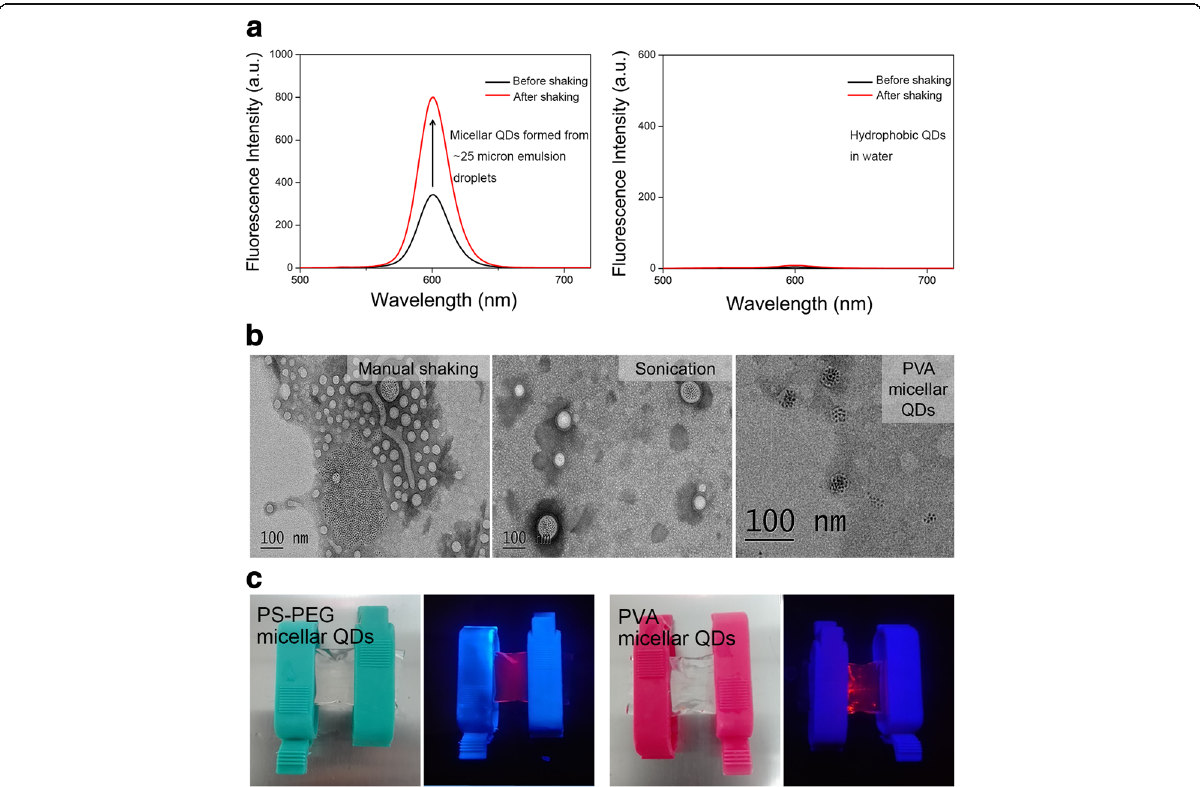
Fig. 3 Examining the colloidally unstable part of the micellar QDs. a Left , the disappearance of fluorescence of the colloidally unstable part of the micellar QDs from the dispersion after 10-day storage could be resumed after the dispersion was shaken. Right , the fluorescence of hydrophobic QDs was not detected in water because they could not be dispersed in water. b Left and middle are the TEM images of the bottom portions of the micellar QD dispersions formed from manual shaking for 1 min (i.e., ~25 μ m emulsion droplets) and sonication for 30 s (~3 μ m emulsion droplets), respectively, after 10-day storage. Right , TEM image of PVA micellar QDs. c Dialysis (against water) treatment on PS-PEG micellar QDs ( left ) and PVA micellar QDs ( right ), respectively. A hand-held UV lamp was used to excite the red QD